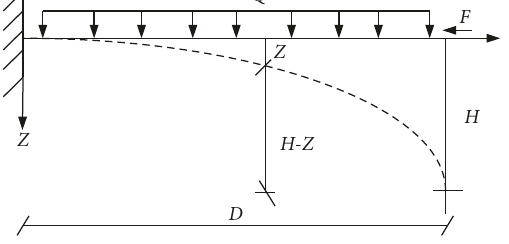
Figure 5: Uniform